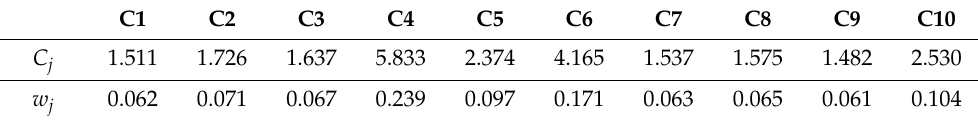
Table 6. Values of C j and weight values of